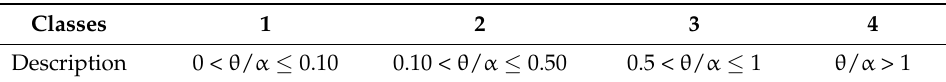
Table 4. Adopted classification of the EDP.